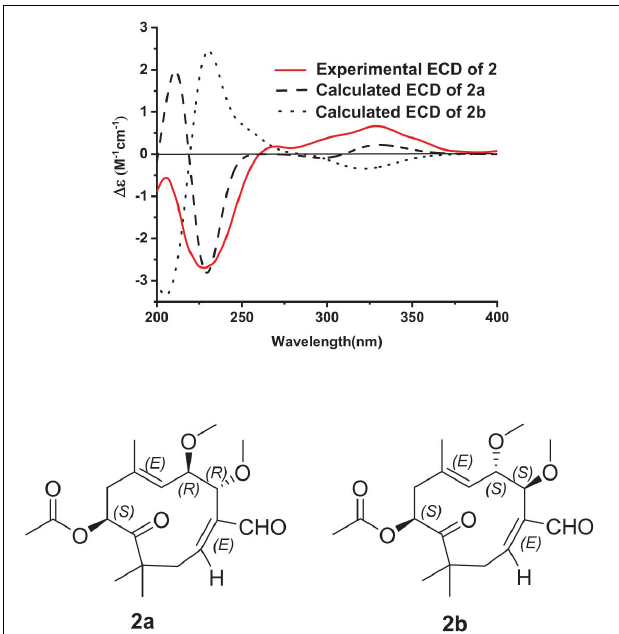
FIGURE 5 | Experimental ECD spectrum of 2 in MeOH and the calculated ECD spectra of 2a and 2b .